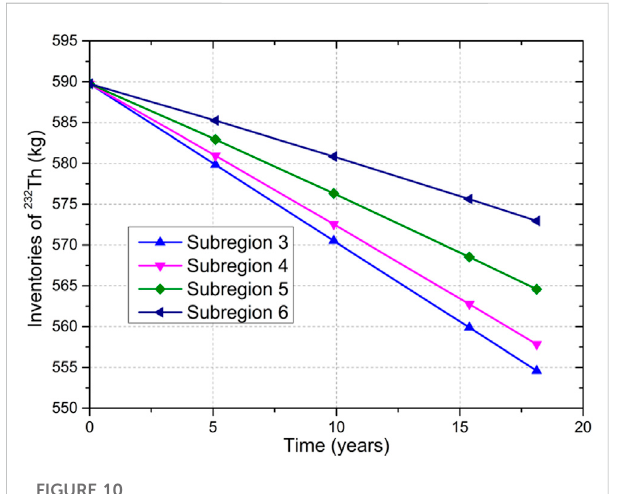
FIGURE 10 Time evolutions of 232 Th inventories in the subregions.